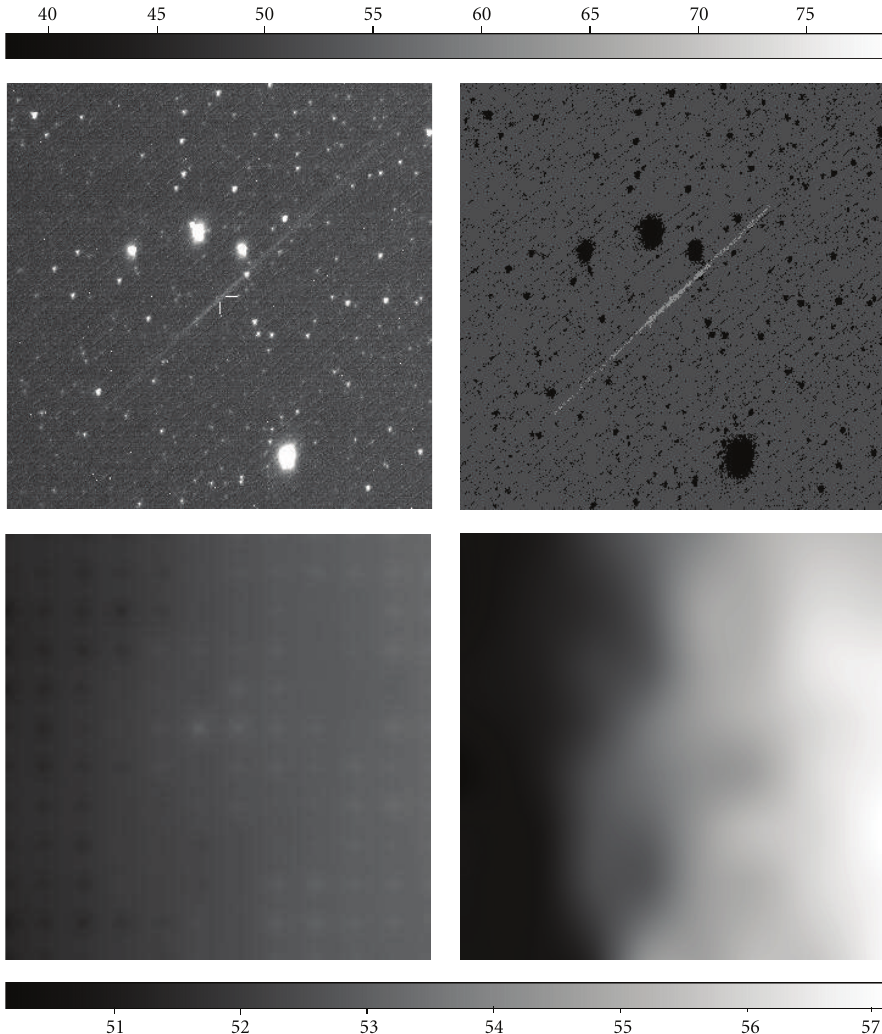
Figure 11: (1) Image of a meteor on a 3 ◦ × 3 ◦ frame ( F ( i , j )). (2) Extraction map. Black shade shows the points with F ( i , j ) > n σ · Σ ( i , j ); white shade indicates the points included into the object under study. Grey shade indicates the background. (3) Background map—(Bg( i , j )) (bottom left). (4) More exact map of a background use SExtractor background estimation algorithm